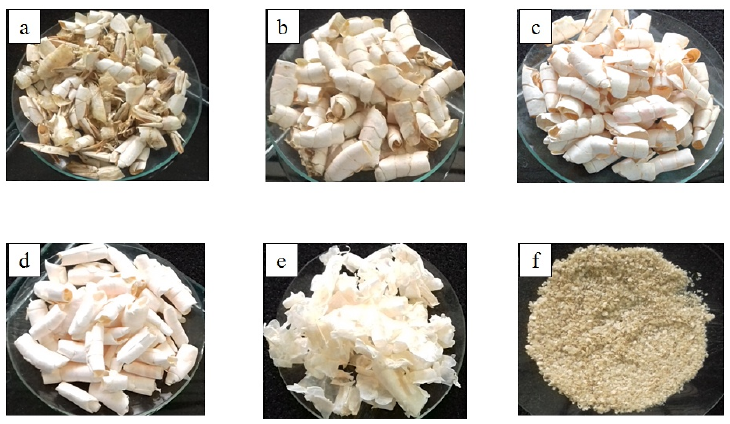
Figure 1. Images of ( a ) raw prawn shells, ( b ) prawn shells after sorting, ( c ) prawn shells after wash- ing, ( d ) prawn shells after deproteinization, ( e ) prawn shells after demineralization, (i.e., chitin) and ( f )